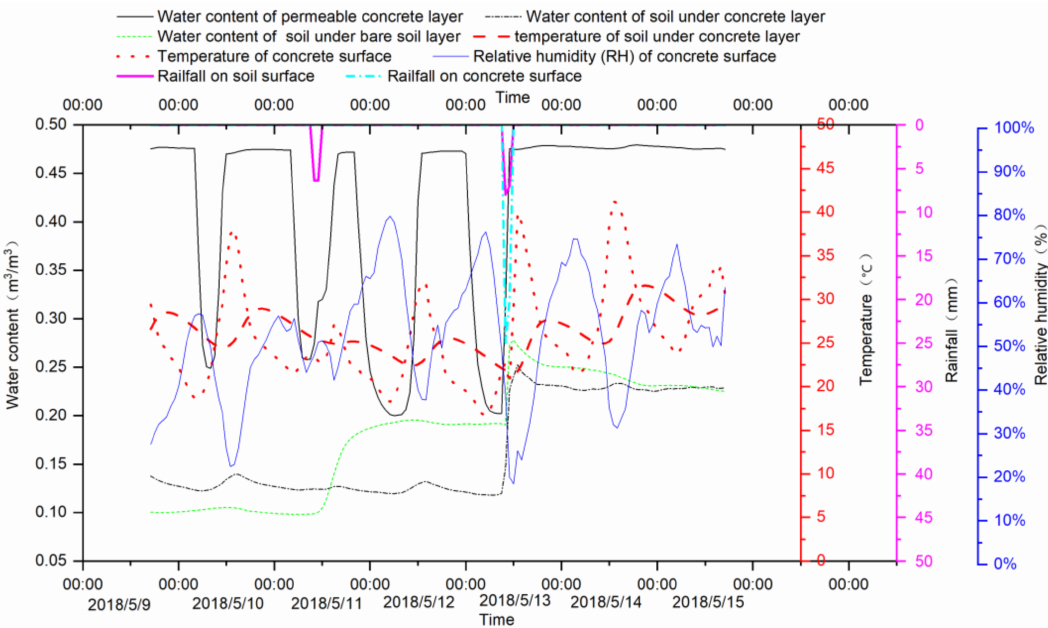
Figure 7. Monitoring results of permeable concrete pavement in the comparison of bare soil